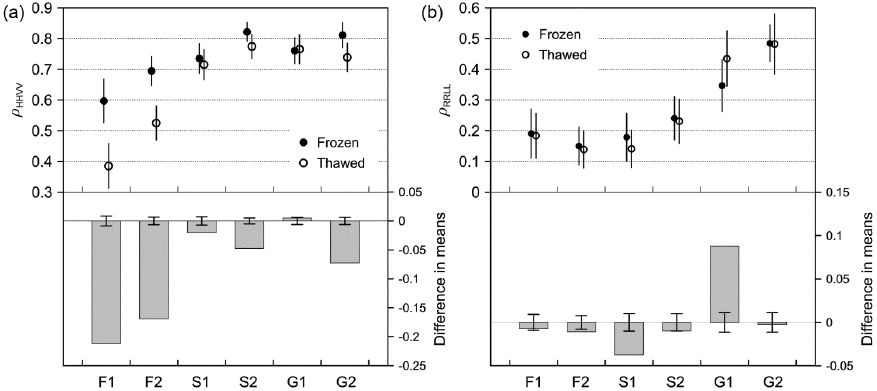
Figure 7. Seasonal variations of ( a ) ρ HHVV and ( b ) ρ RRLL for the test sites. Vertical error bars in the lower plot indicate the 99% confidence interval for the hypothesis test H 0 : µ thawed “ µ frozen